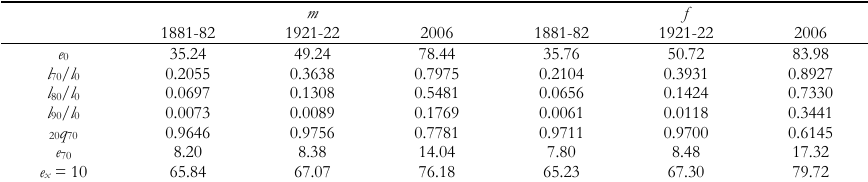
Elderly survival and mortality in Italy, 1881-2006